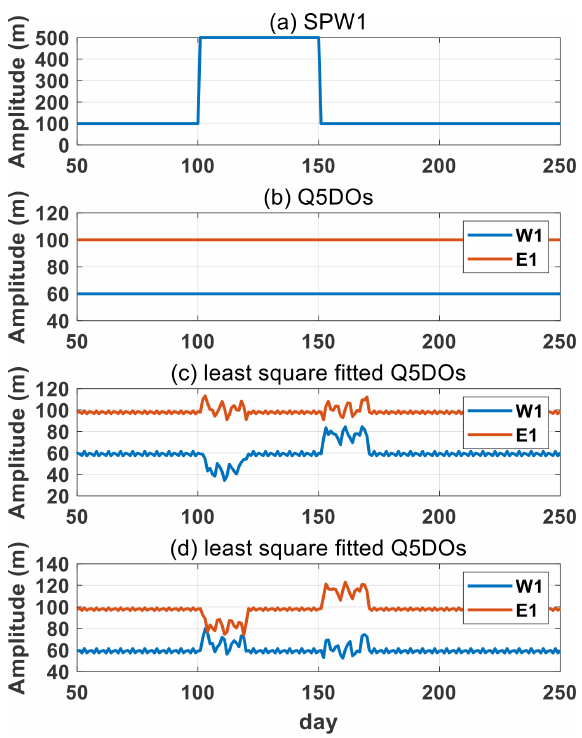
Figure 1. Simulations of the least squares fitting method based on synthetic data, including an SPW and westward and eastward Q5DOs with a zonal wave number of 1. (a) Daily variations in the SPW amplitudes. The phase of the SPW is 0. (b) The real ampli- tudes of Q5DOs. Amplitudes are separately set as 100 and 60m for the respective eastward and westward Q5DOs. (c) Q5DOs obtained from the least squares fitting method. The phases are − π/ 4 and π/ 5 for the westward and eastward Q5DOs, respectively. Panel (d) is the same as panel (c) but with phases of π/ 4 and − π/ 5 for the west- ward and eastward Q5DOs,